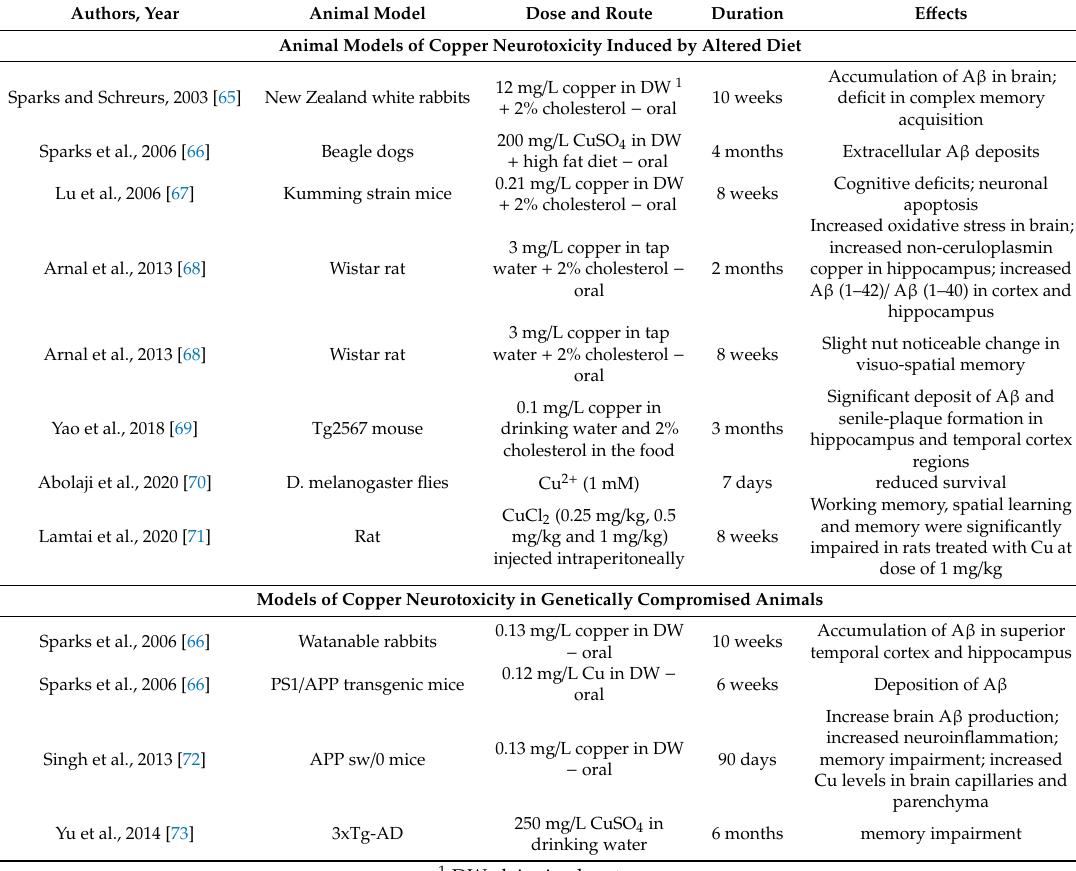
Table 2. Experimental models focused on the investigation of the causative correlation of copper and non-ceruloplasmin copper in Alzheimer’s disease (AD) development and